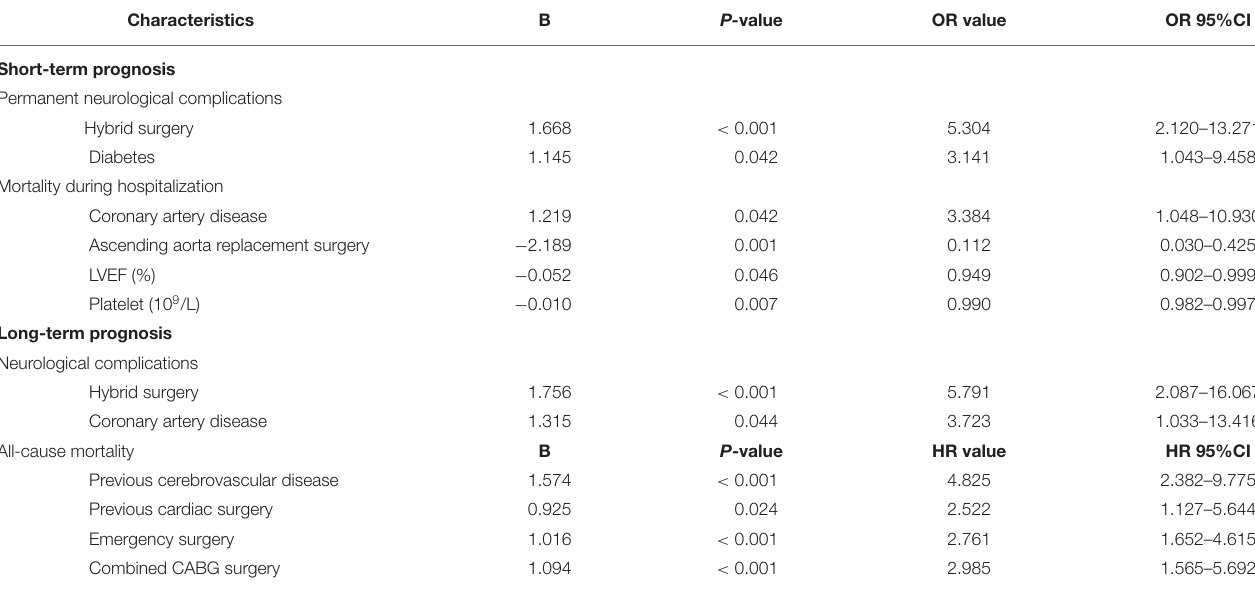
TABLE 5 | Multivariate regression results of post-operative mortality and neurological